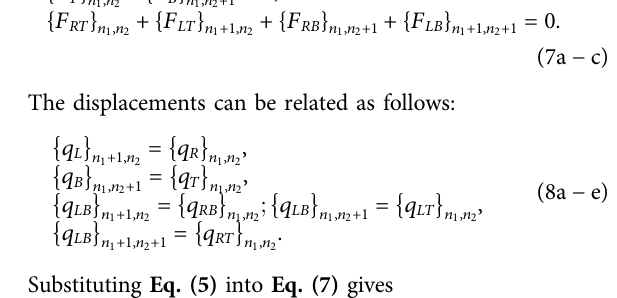
FIGURE 4 | Geometry of the arbitrary triangular shallow shell element (Cowper et al., 1970)